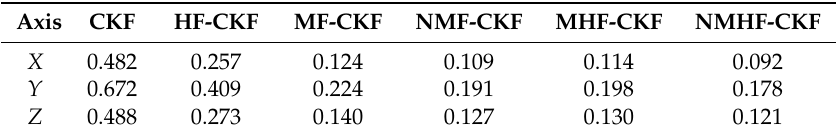
Table 4. Position RMSEs of each scheme (meter).